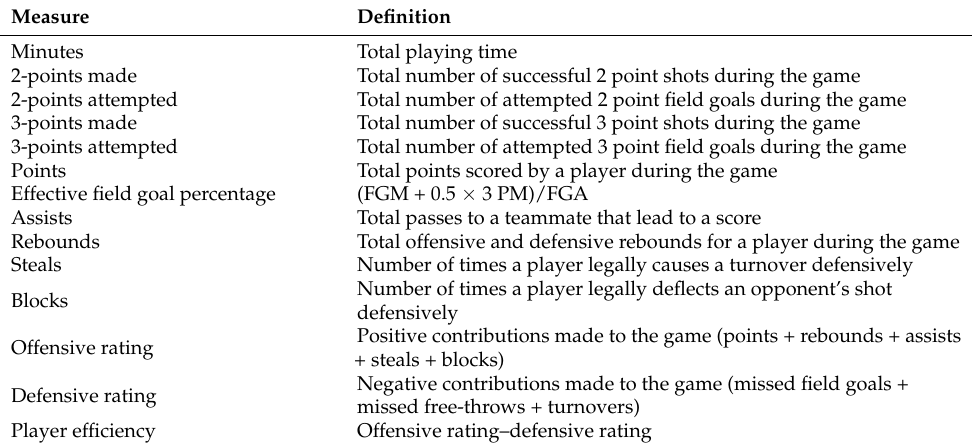
Table 3. In-game performance measures used in this study and their associated definitions